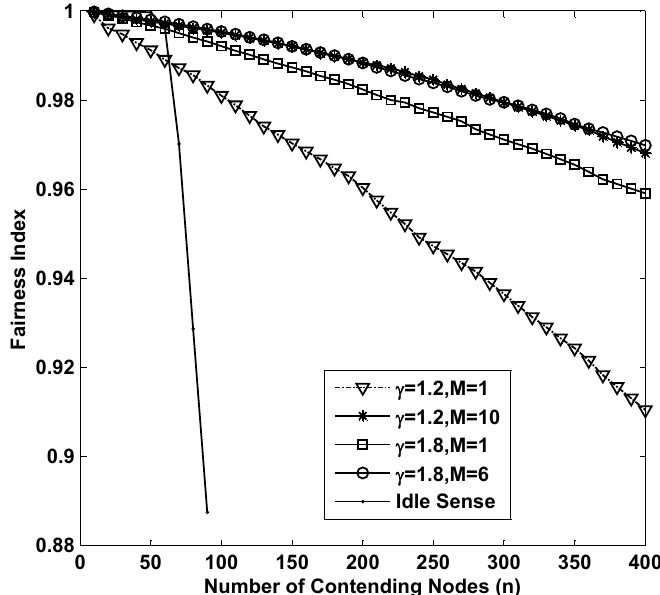
Figure 6. The fairness performance of M -level contention window tuning algorithm with different M and γ and idle sense algorithm for super dense deployed